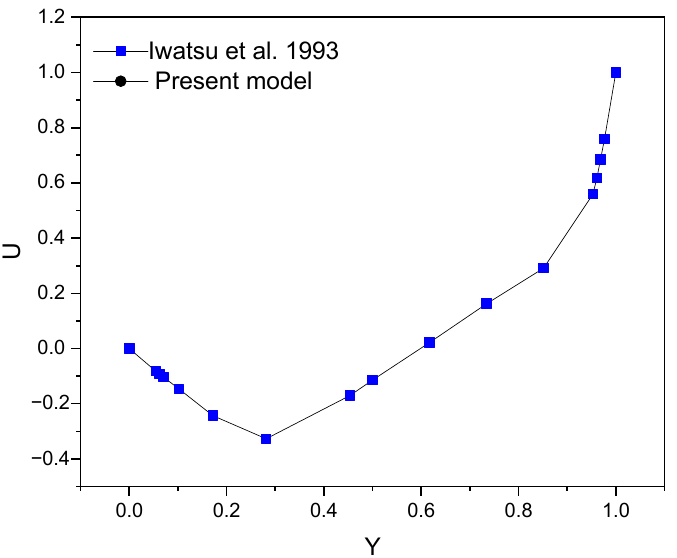
Figure 2. Validation of the code velocity profile (Comparison of a new result with that of Iwastu et al. [25] for a limiting